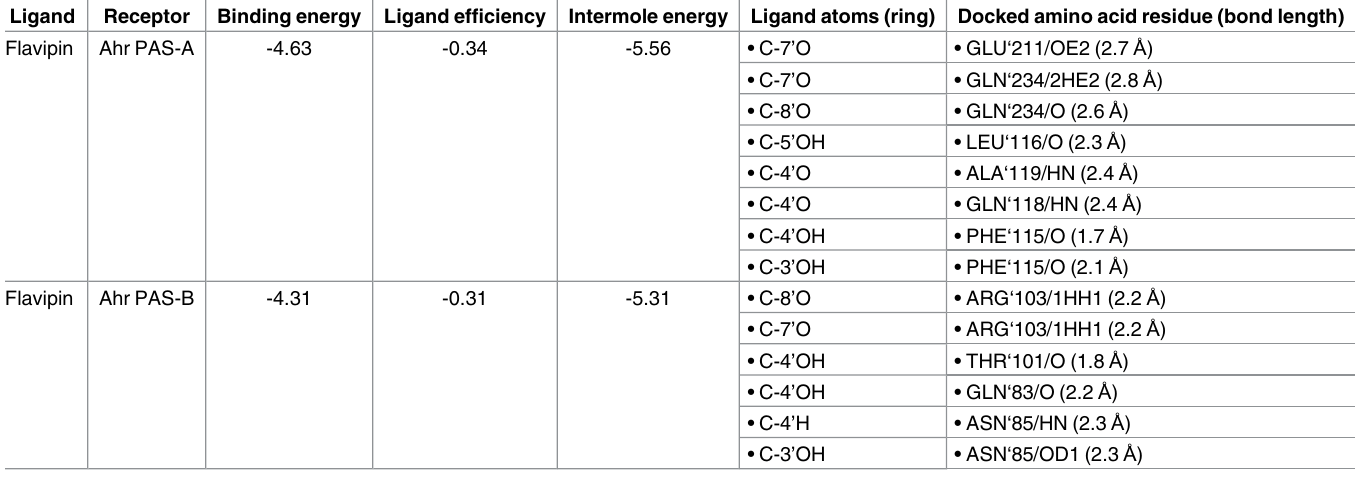
Table 1. Molecular docking of Flavipin with Ahr PAS-A and PAS-B domain.